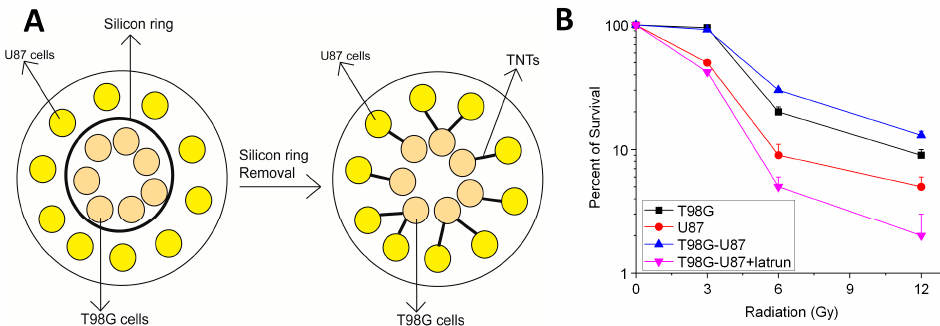
Figure 3. TNTs enable the transfer of protective agents to cancer cells that are susceptible to radiation and chemical treatment. ( A ) Using a silicon coculture system as described, T98G (glioblastoma, resistant to radiation and temozolomide (TMZ) treatment) and U87MG cells (glioblastoma, sensible to radiation and TMZ treatment) were cocultured to examine survival. Upon removal of the silicon barrier, both cell types could form TNTs and communicate with each other. ( B ) Quantification of the survival of T98G and U87 cells alone (back line and red line, respectively) and cocultured U87 cells (blue line). In this case, T98G cells are more resistant to radiation than U87 cells (0 to 12 Gy). However, upon coculturing and the subsequent formation of TNTs, T98G cells transfer the radiation resistance to U87 cells (blue line). The transfer of resistance was dependent on TNT formation, because the use of latrunculin (latrun), a TNT blocker, prevented the transfer of resistance into U87 cells (pink line). Thus, the TNT formation transfers a protective agent against radiation treatment from T98G to U87 cells. Thus, TNTs are essential to spreading chemical and radiation resistance into surrounding